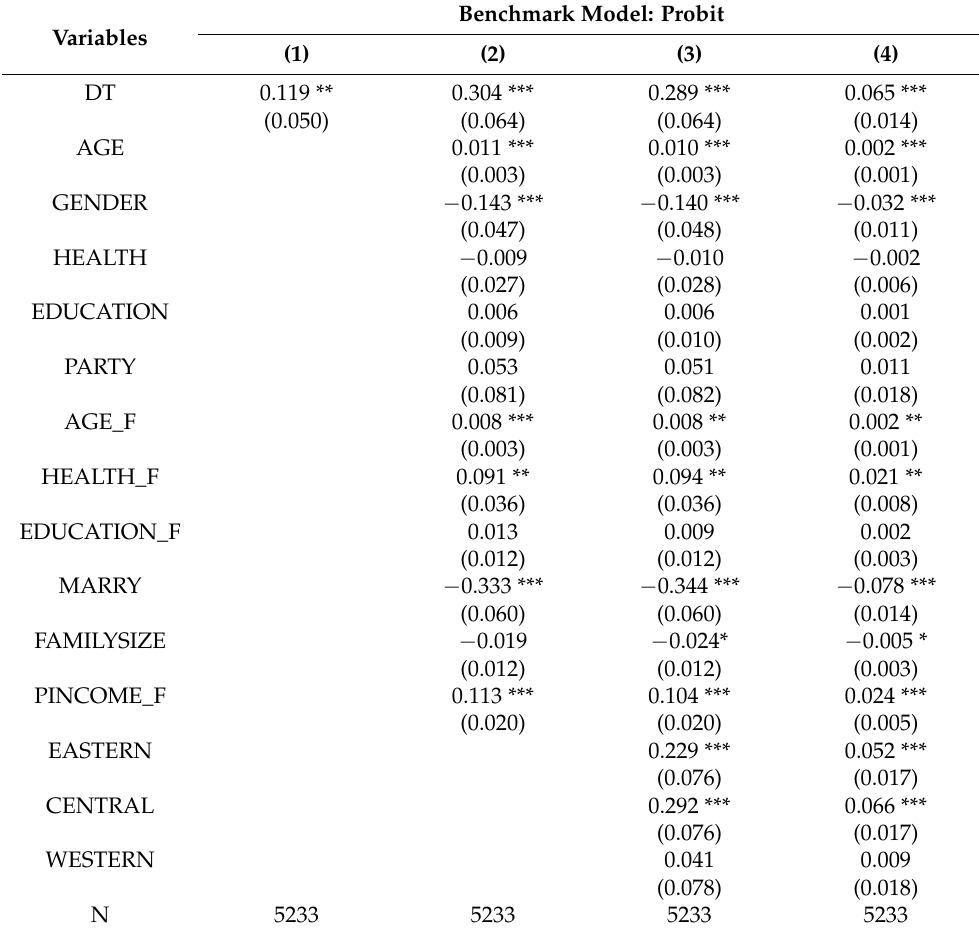
Table 3. The impact of DT on LRB: benchmark model test results.